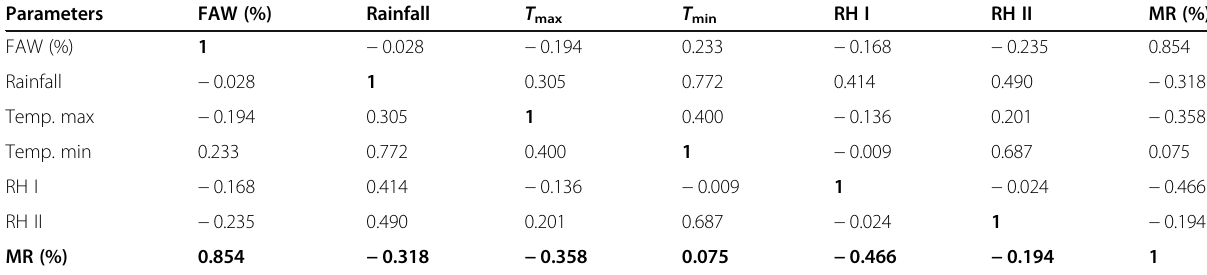
Table 3 Correlation matrix of natural incidence of Metarhizium rileyi under field conditions during study period Parameters FAW (%) Rainfall Rainfall Temp.